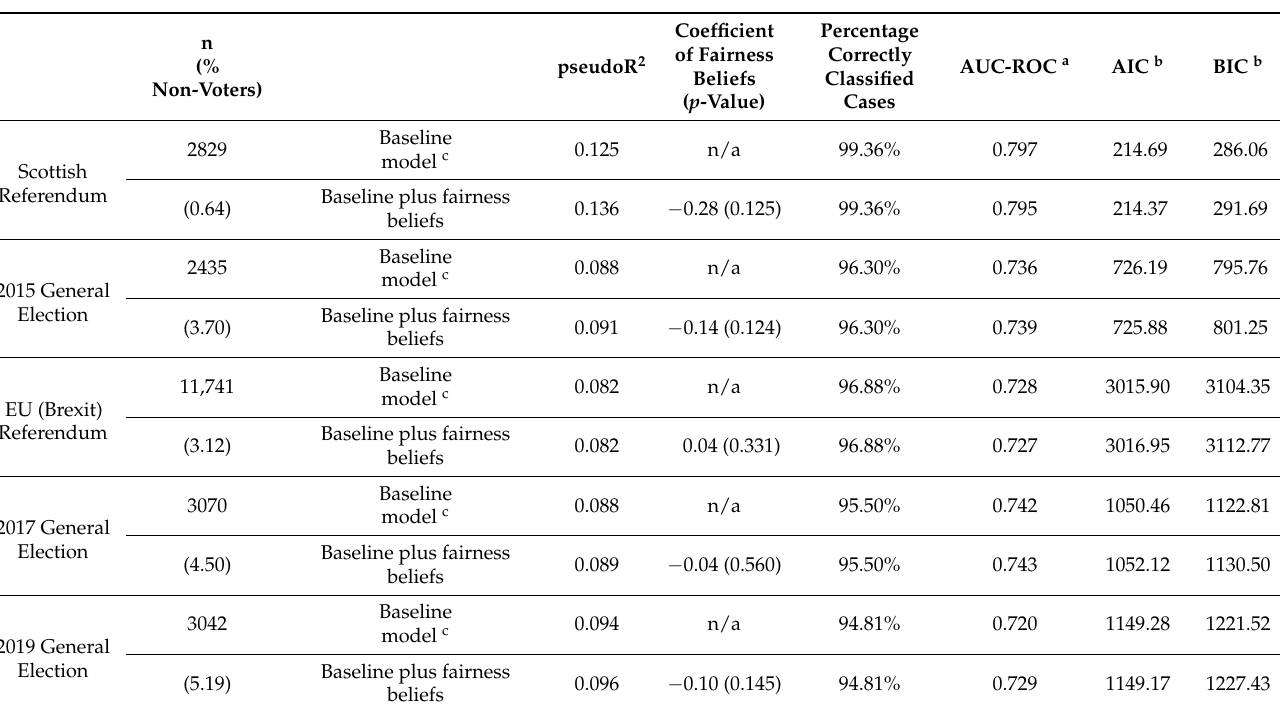
Table 6. Block-recursive logistic regressions of turnout on baseline model and prospective fairness